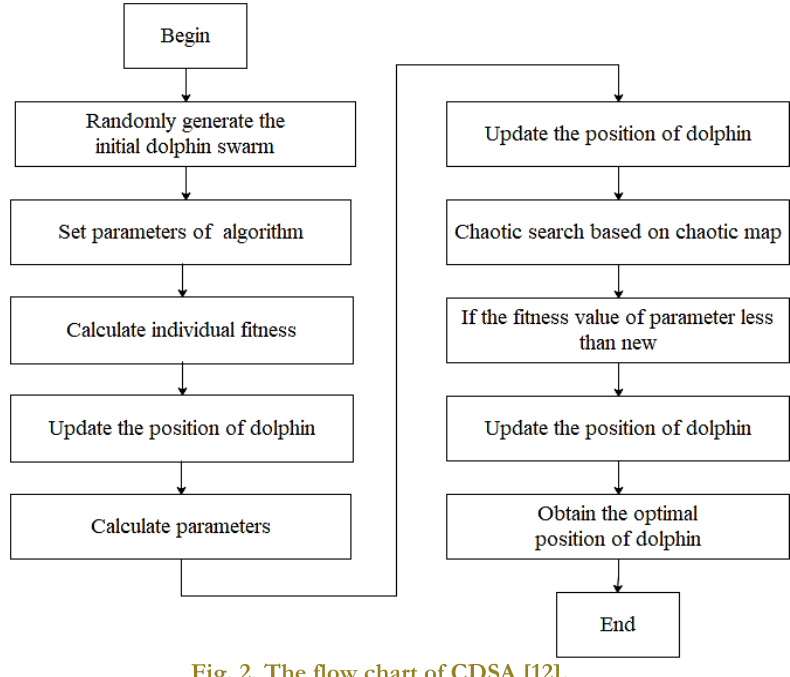
Fig. 2. The flow chart of CDSA